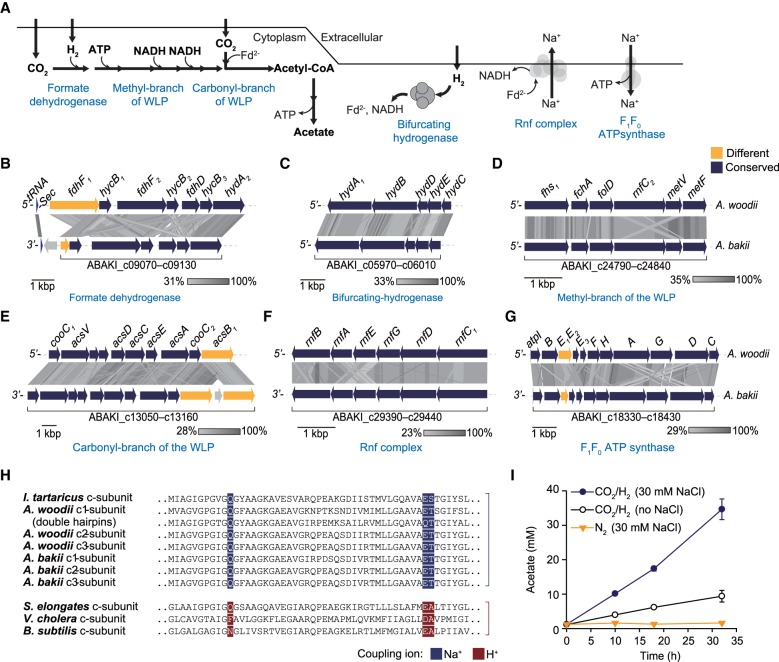
The WLP of A. bakii. (A) Schematic representation of the putative acetogenesis in A. bakii. (B–G) Synteny analysis of major gene clusters involved in acetogenesis between A. bakii and A. woodii. Comparisons were performed using tBLASTx within Easyfig (Sullivan et al. 2011), and each arrow indicates a gene. Genetic conservation is represented by a color. (H) Comparison of the sequences of the c-subunits of ATP synthase. These c-subunits assembled into homo- or heteromeric c-rings and play a direct role in ion translocation across the membrane. To determine the Na+/H+ binding motif, the c-subunit sequences of F1F0-type ATP synthase complex were aligned. The Na+/H+ binding motif, either predicted (A. bakii) or known (other strains), is highlighted in color in each case. Used c-subunit sequences were obtained by the following accession numbers or locus_tags: Ilyobacter tartaricus (Q8KRV3), Acetobacterium woodii (Awo_c02160 – c02180), Acetobacterium bakii (ABAKI_c18390–c18410), Synechococcus elongates (YP_399351), Vibrio cholera (Q9KNH0), and Bacillus subtilis (P37815). (I) Resting cell assay was performed with or without 30 mM NaCl. The whole cell of A. bakii (0.25 mg/mL) was incubated with 50 mM imidazole, 20 mM MgSO4, 20 mM KCl, 4.4 µM resazurin, 4 mM DTE at pH 7.0. The gaseous atmosphere was H2–CO2 (80:20, v/v, 200 kPa) or N2 (200 kPa). All values are means obtained from two independent experiments.